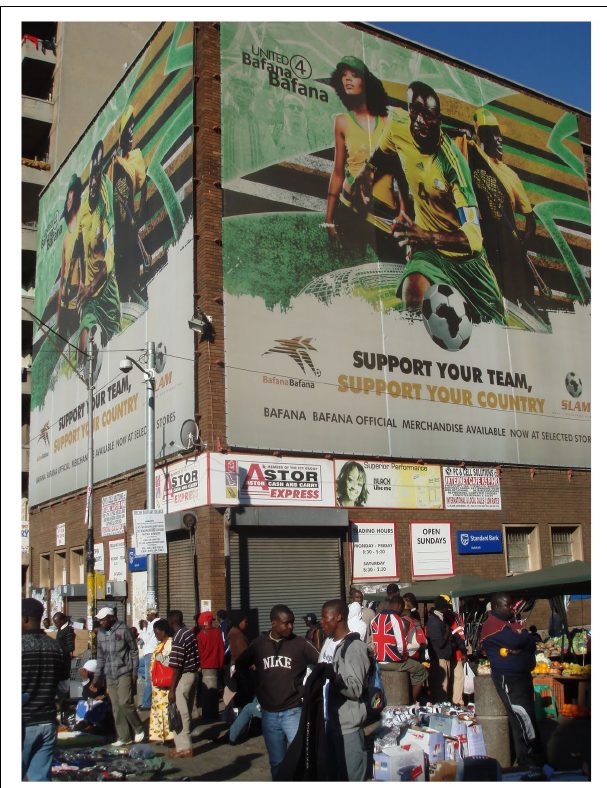
FIGURE 3 | Example of widespread small narratives indicating the normativity of support for the national team and national